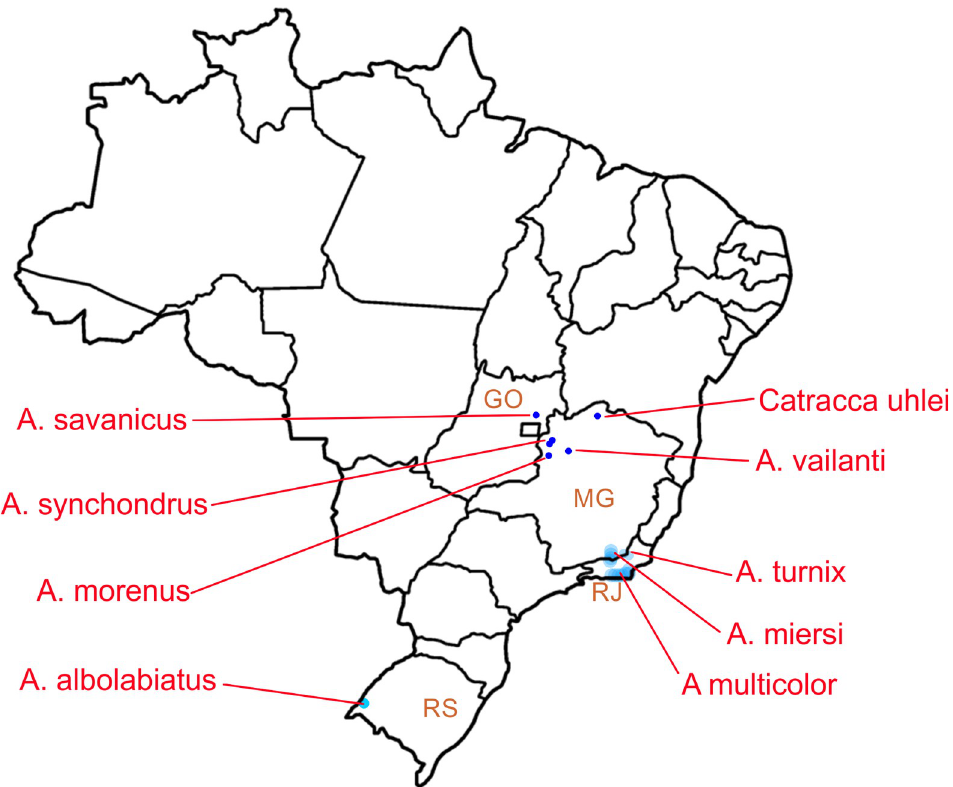
Fig 28. Self-produced Brazil map with states outlined and type localities of each Anthinus ( A .) and Catracca shown. New localities in dark blue. Previous localities in light blue. States abbreviations: GO: Goia´s; MG: Minas Gerais; RJ: Rio de Janeiro; RS: Rio Grande do Sul. 15. Pulmonary septum: 0 = absent; 1 = present. 16. Nephropore: 0 = protected in primary ureter; 1 = exposed in pallial cavity. 17. Nephropore: 0 = simple; 1 = protected by anterior renal fold (? in outgroup). 18. Kidney: 0 = smooth; 1 = covered by anastomosed net of vessels. 19. Urinary pallial way: 0 = via duct; 1 = via groove. 20. Ureter groove: 0 = smooth; 1 = transversely folded. 21. Jaw plate: 0 = smooth; 1 = transversely folded; 2: narrow. 22. Horizontal muscle (m6): 0 = present; 1 = absent. 23. Insertion of pair m5: 0 = on pair m4; 1 = partially on cartilages. 24. Pair of muscles inside radular sac (m7): 0 = present; 1 = absent. 25. Inner edge of cartilages (anterior to fusion): 0 = thick; 1 = thin. 26. Radular teeth: 0 = rachidial similar to lateral; 1 = different. 27. Radular teeth: 0 = bi- or multicuspid; 1 = unicuspid. 28. Radular mesocone: 0 = smaller than base; 1 = as long as base; 2 = longer than base.